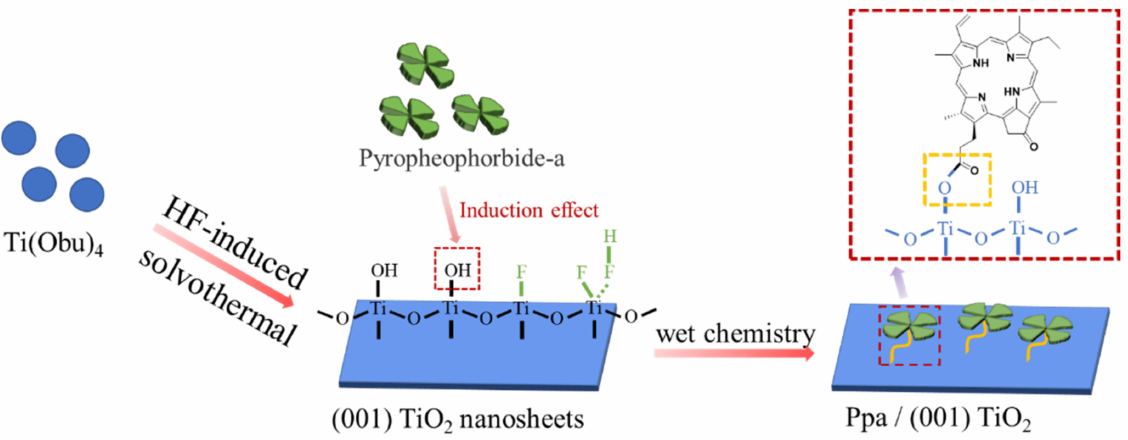
Scheme 1. Synthetic illustration of the Ppa/001T heterojunction.